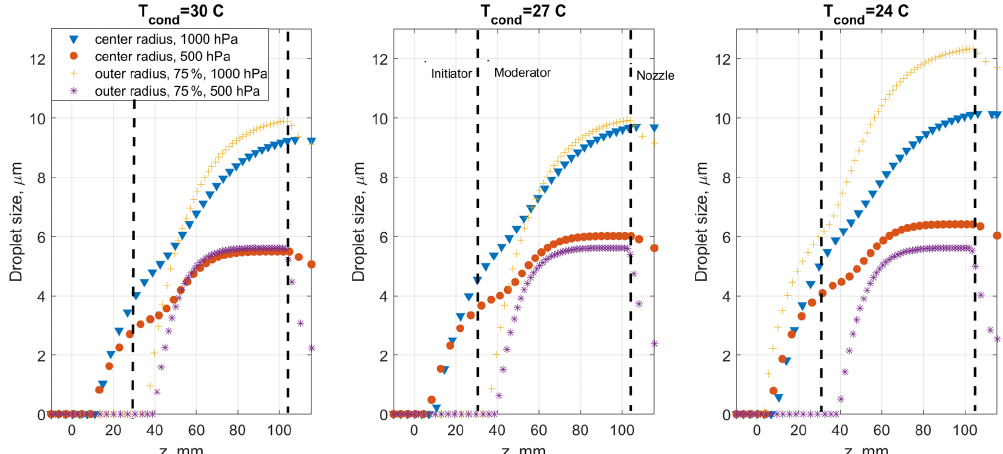
Figure 5. Predicted droplet size evolution along the growth tube (at centerline or 75% of the inner tubing radius) of the vWCPC 3789 under the different conditioner temperatures (30, 27, and 24 ◦ ) with the initiator temperature at 59 ◦ and the moderator temperature at 10 ◦ . Starting particle size 8nm. The dashed lines indicate the starting and ending locations of the